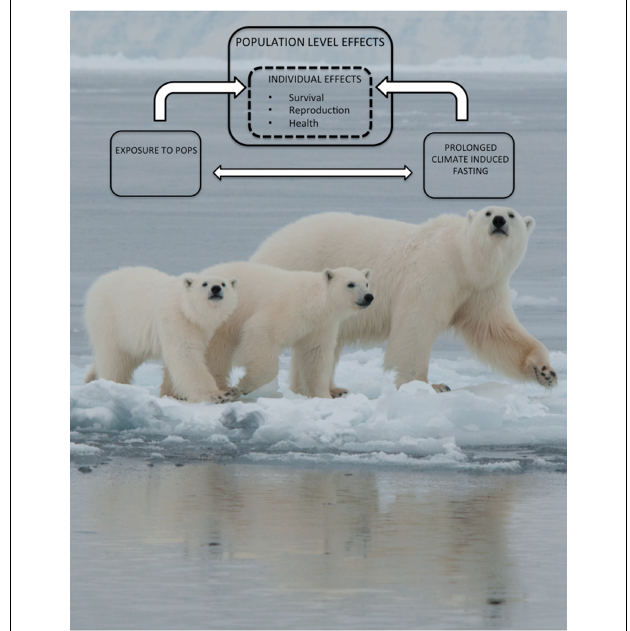
FIGURE 1 | Climate change induced fasting and exposure to persistent organic pollutants (POPs) are anthropogenic stressors that have the potential of affecting the individual health, reproduction and mortality of polar bears. Prolonged fasting may increase tissue concentrations of POPs and thus enhance negative fitness effects, whereas high levels of POPs may cause metabolic effects that interfere with fasting tolerance. Effects on the individual level propagate to population levels. Photo: Rune